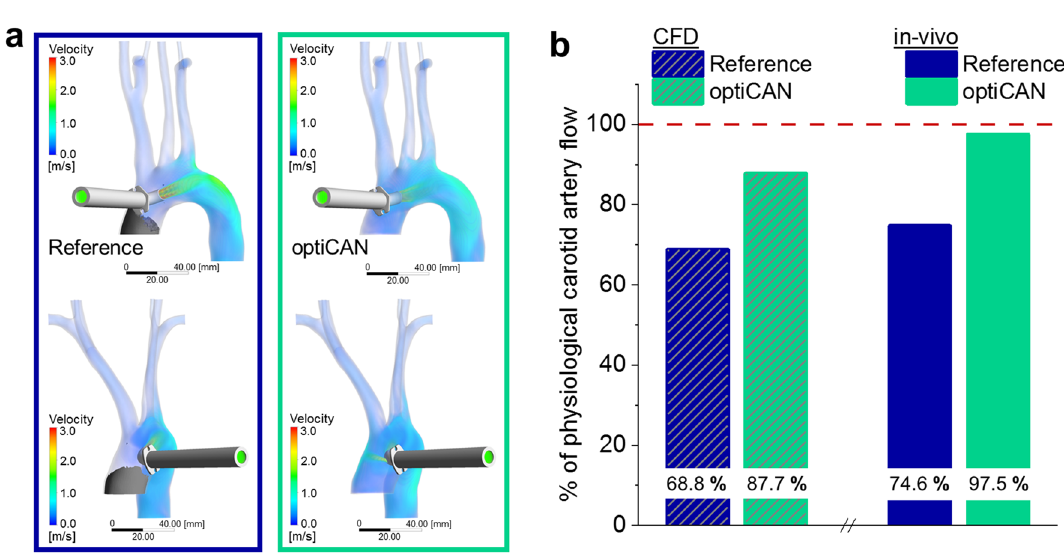
Figure 3. CFD simulation results for a human anatomy. ( a ) Flow field in the aorta and supra-aortic vessels for reference (left) and optiCAN cannula (right) in anterior view (upper) and left lateral view (lower). Gray shades mark the area of low blood flow (velocity below 0.01 m/s). ( b ) Comparison of carotid artery flow (normalized to physiological cerebral flow) comparing reference cannula with optiCAN design from CFD simulation (shaded) and in vivo animal trial. (cf. Fig. 2b). Dashed line marks physiological cerebral